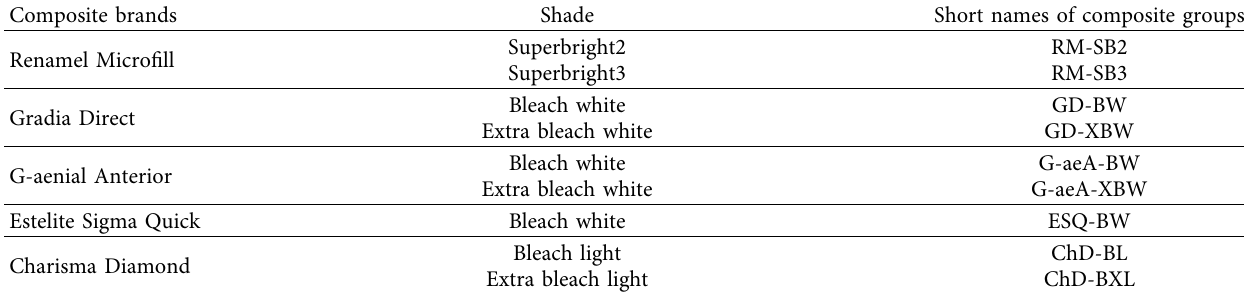
Table 1: Short names of composite